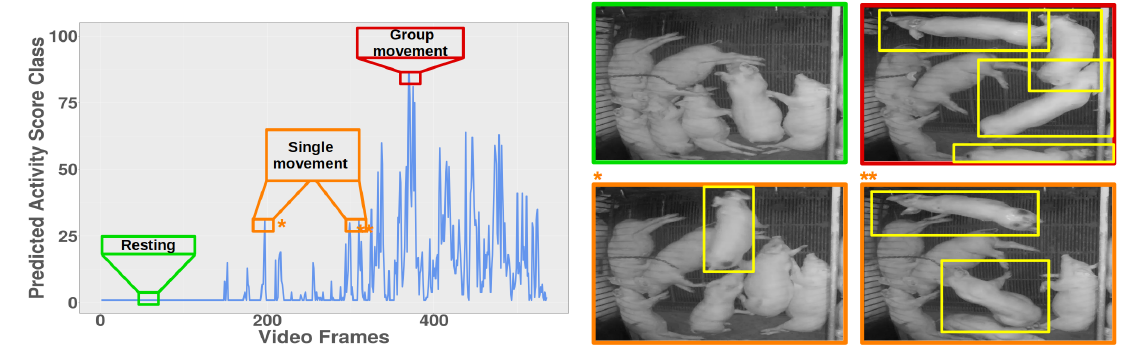
Figure 5. Progression of the predicted activity score classes for a randomly selected nine-minute video. The images on the right side correspond to the highlighted score classes marked with their frame color. Green frame: very low activity score classes correspond to situations like resting behavior in which no movement activities occur. Orange frame: an increase in the score classes correspond to an activity increase of individual animals, e.g., a single animal walking (*) or two animals changing their body posture (**). Red frame: the occurrence of high score classes are in line with strong behavior activities caused e.g., by the simultaneous interaction of several